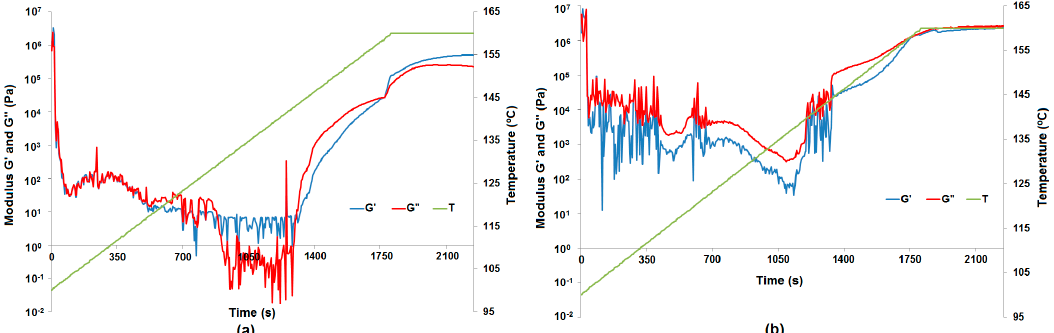
Figure 9. Phase transformation of resin with pure Al 2 O 3 represented by the moduli G ′ and G ″ ( a ) and phase transformation of resin with pure lignin represented by the moduli G ′ and G ″ ( b ).